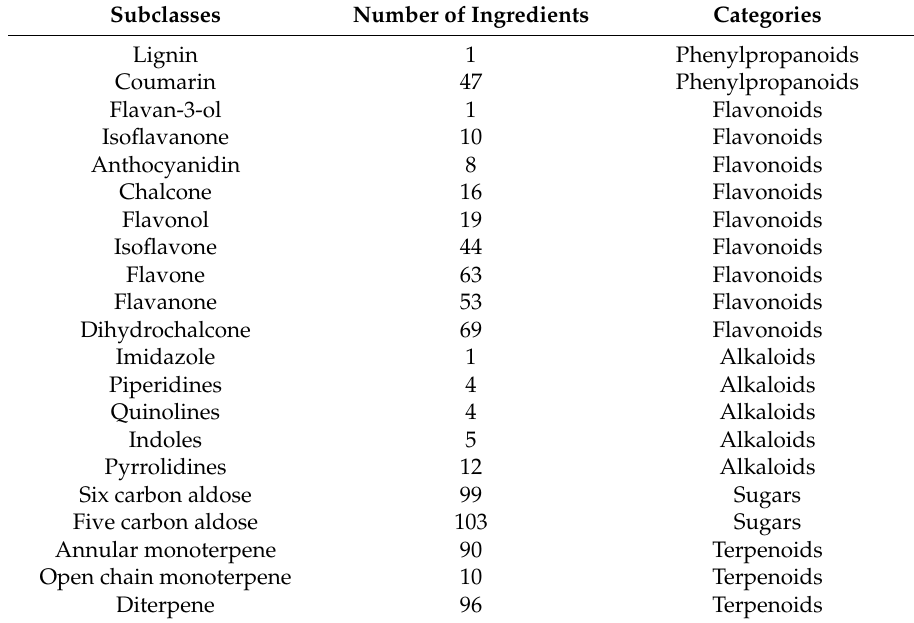
Table 1. Structural categories of ingredients in Wendan decoction